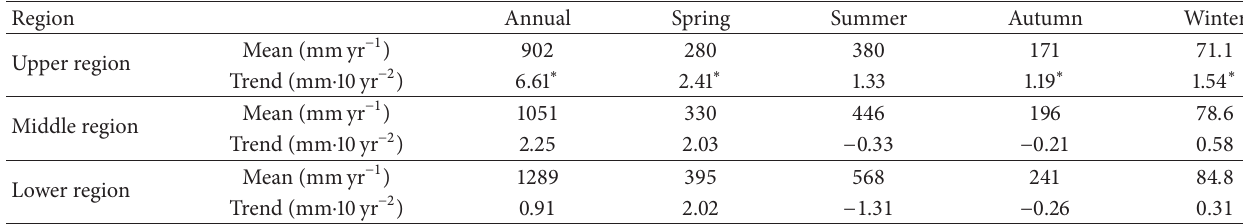
Figure 5: Annual and seasonal ET 0 trends for the HRB during 1961 and 2014. NS means not significant at the level of 𝛼 < 0.05 by the MK test. Table 2: Means of seasonal and annual ET 0 and their trends in the three subregions during 1961–2014.